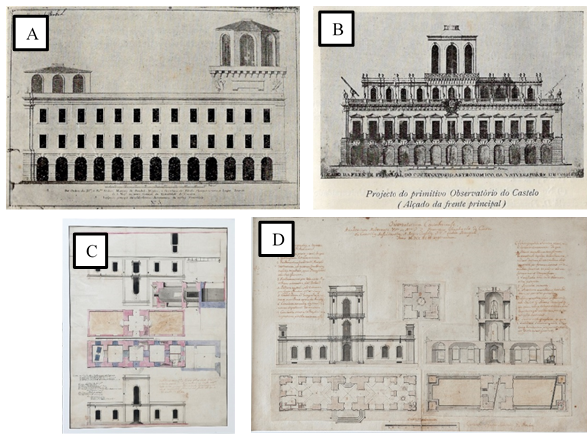
Figure 3. The main building of the Geophysical and Astronomical Observatory of the University of Coimbra (A), together with the entrance (B), the Calouste Gulbenkian Foundation Astronomical Dome (C) where night sky observation evenings are made and the Planetarium